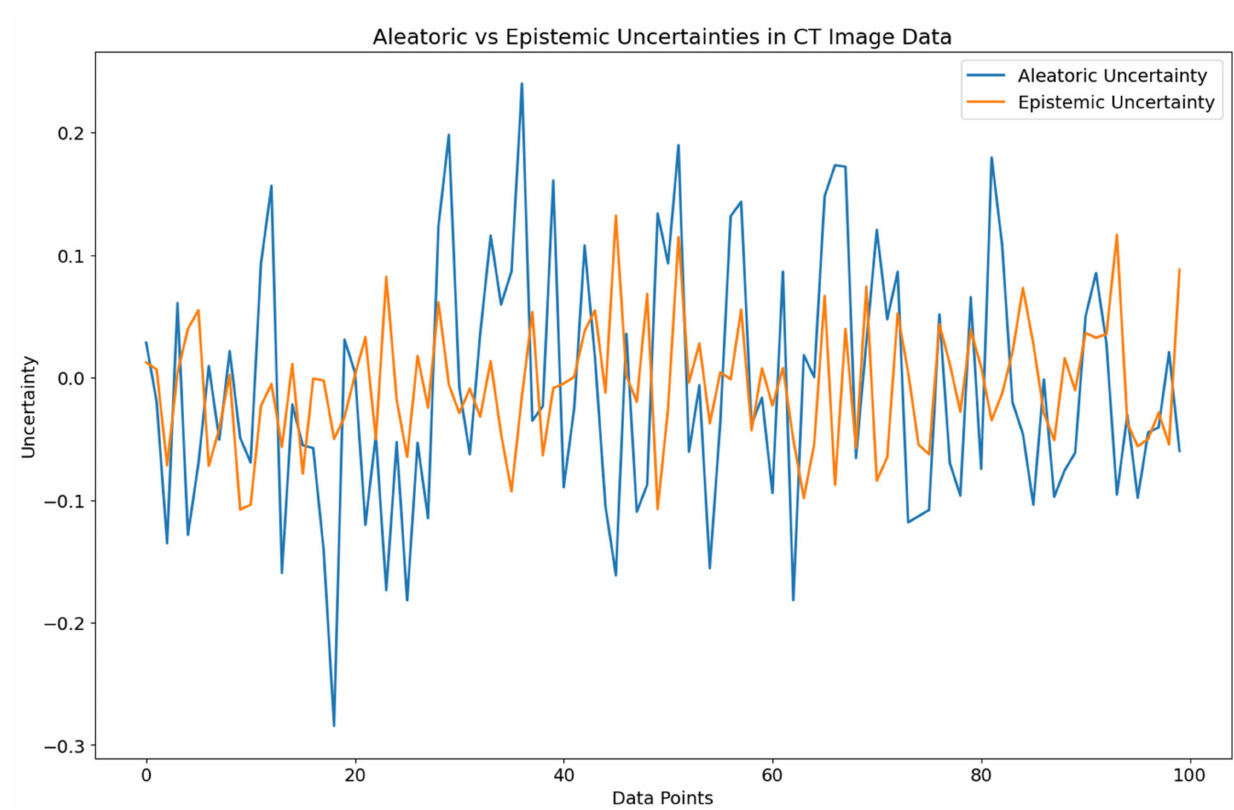
Figure 1. Aleatoric and epistemic uncertainties in the